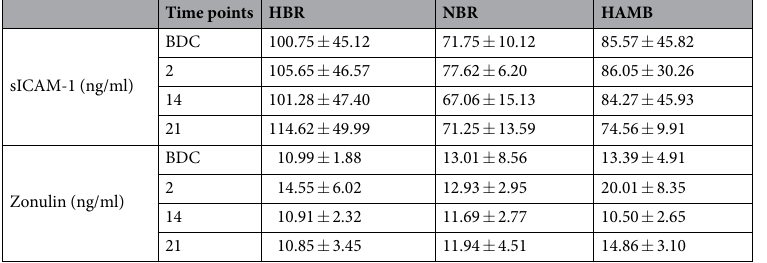
Table 2. sICAM-1 and zonulin; data are means ± SD; units are ng/ml; HBR = hypoxic bed rest (n = 6); NBR = normoxic bed rest (n = 6); HAMB = hypoxic ambulation (n = 6); BDC = Baseline Data